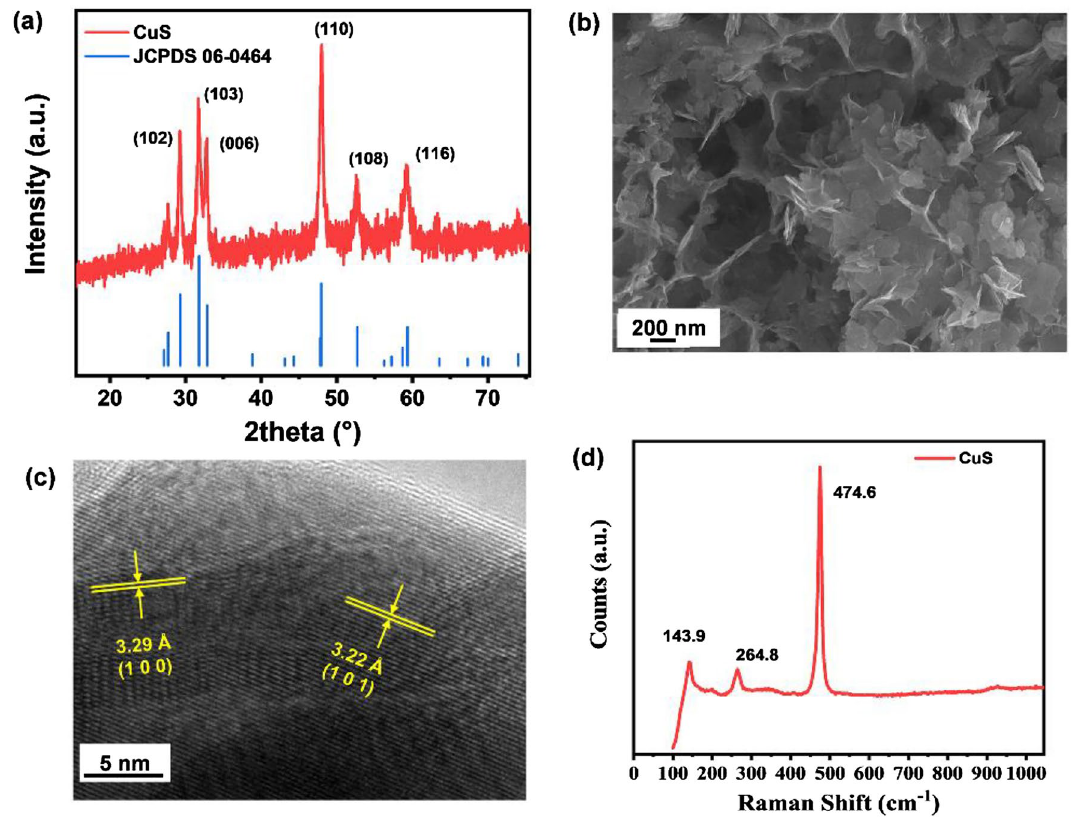
Figure 1. Structure and morphology of CuS: ( a ) XRD pattern, ( b ) SEM image, ( c ) TEM image and ( d ) Raman spectrum of